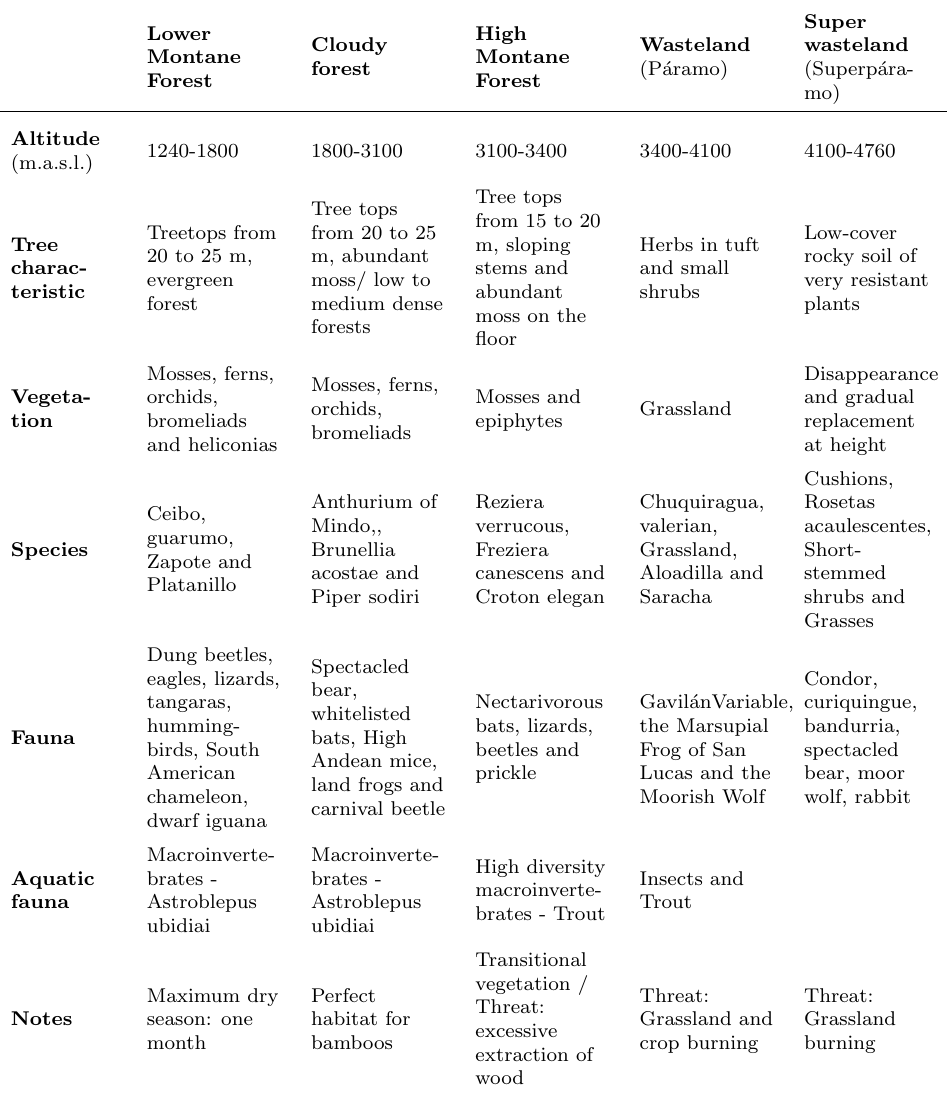
Table 1: Ecosystems of